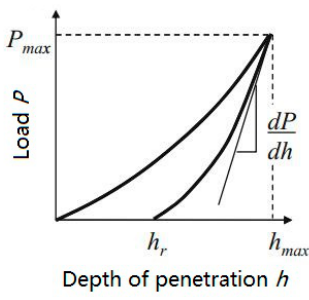
Figure 2. Load-displacement curves for the elastic-plastic solid.